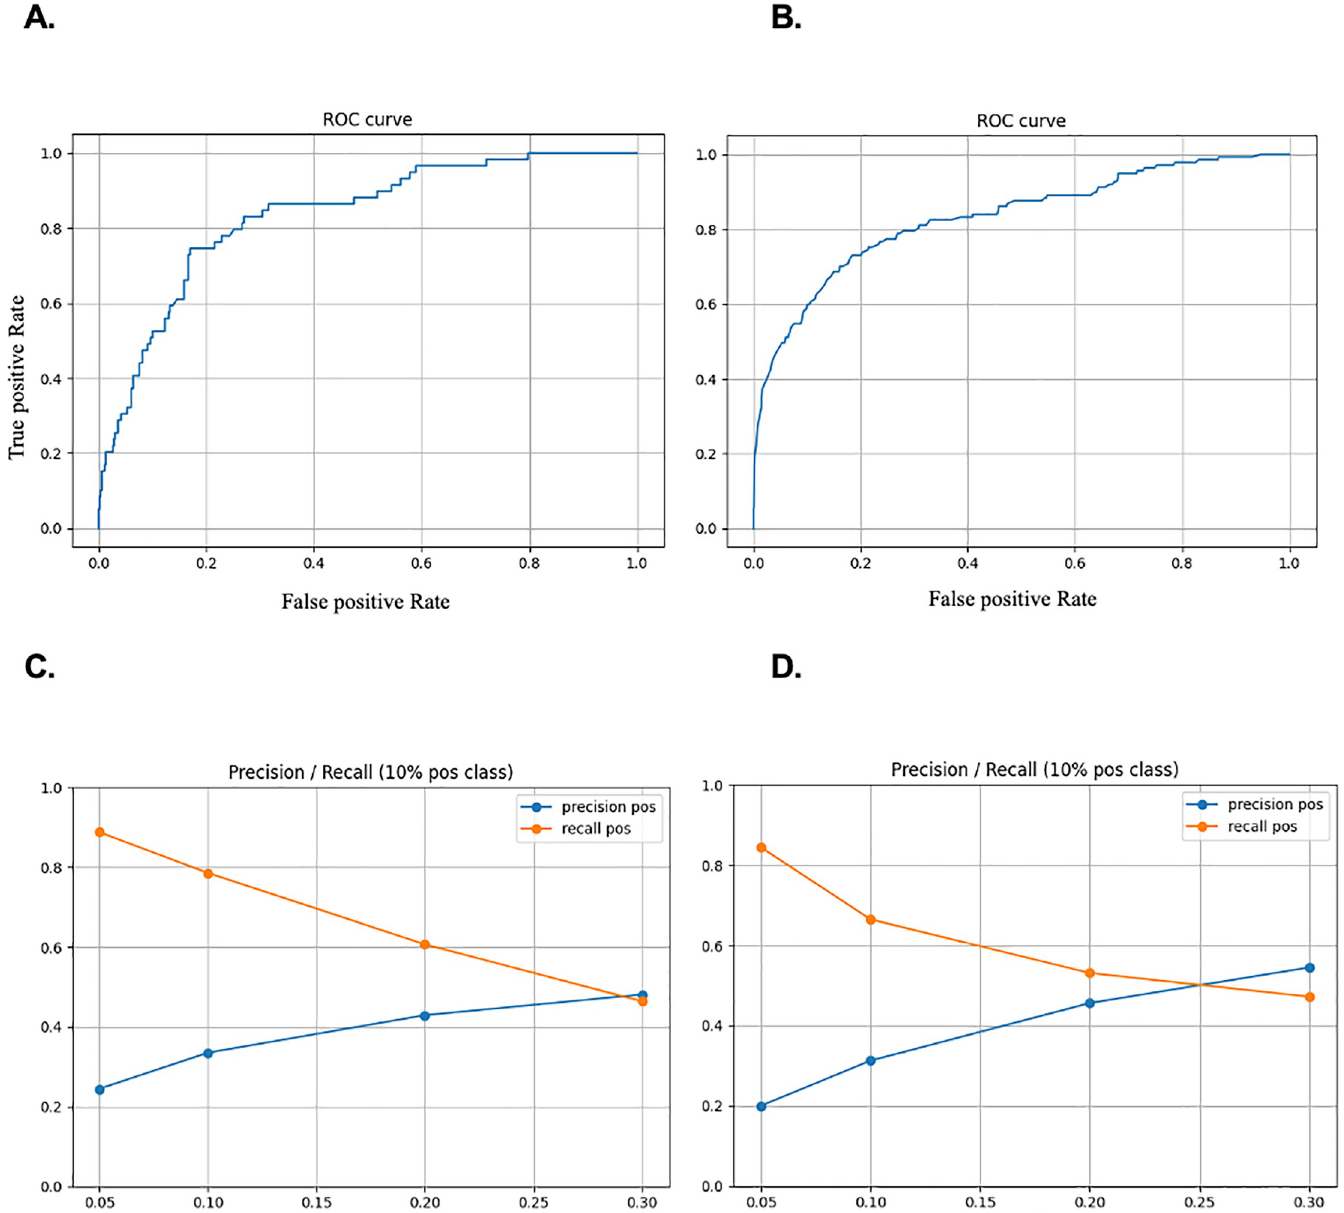
Fig 2. ROC (False Positive Rate vs True Positive Rate) and Precision/recall curves for the forecasting model with (A, C) and without cognitive assessment (B, D).